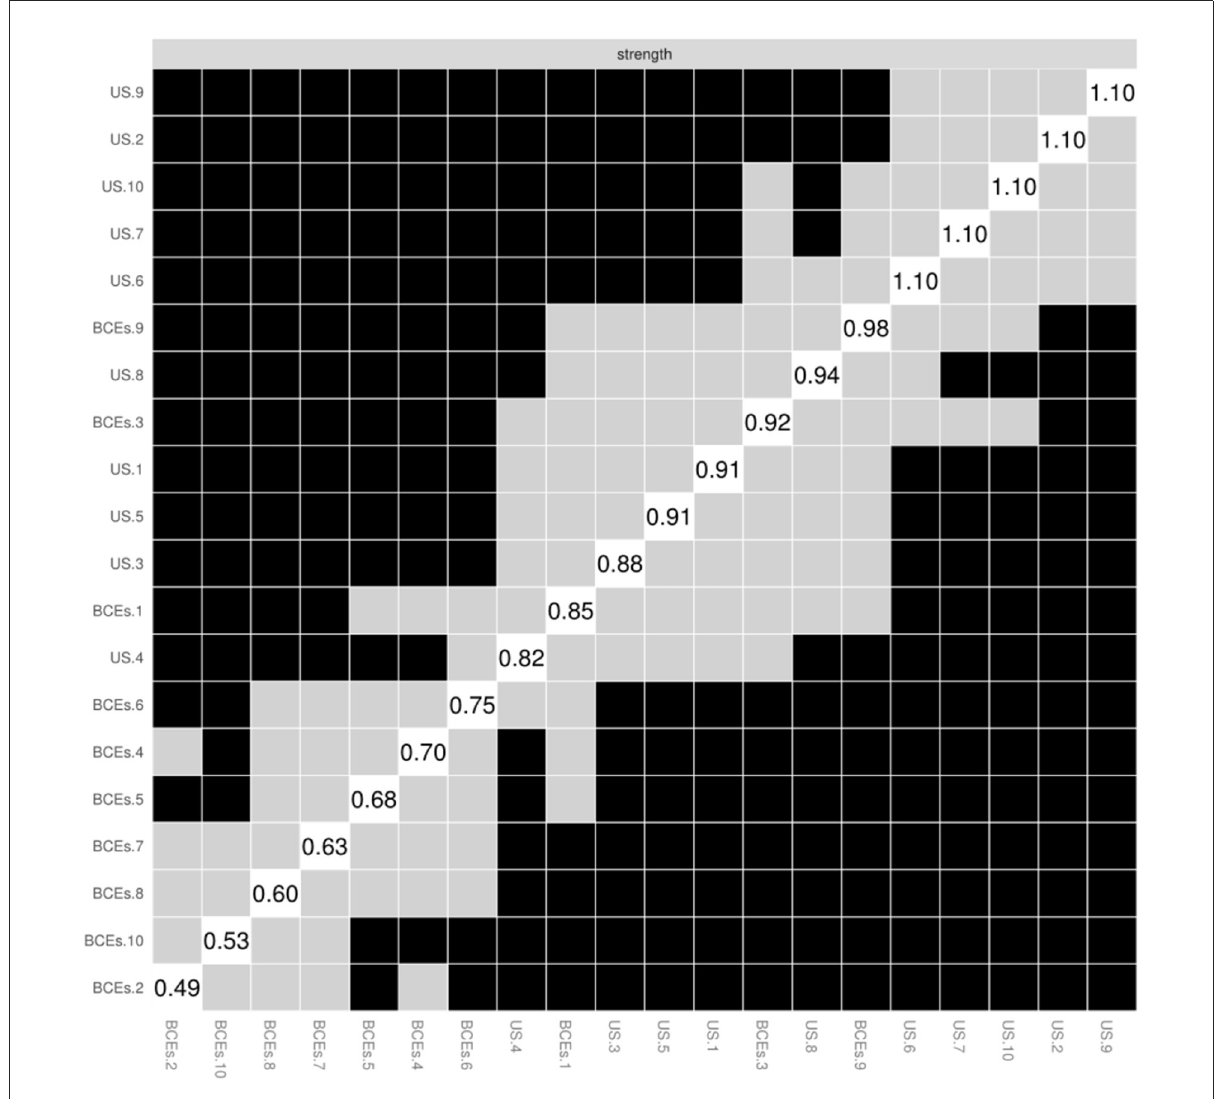
FIGURE4 The node strength was tested using a non-parametric bootstrap difference test. Bootstrap difference tests between node strength of factors. Gray boxes denote nodes that do not significantly differ from one-another. Black boxes represent nodes that differ significantly from one another ( α = 0.05). White boxes show the values of node